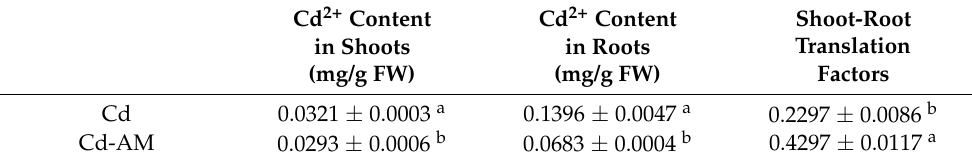
Figure 2. Chlorophyll fluorescence images of (II), Y(NO), Y(NPQ), and qL at steady-state with actinic illumination of 200 µ mol · photons · m − 2 · s − 1 measured at the end of the experiment in leaves of different treatments. The false color code depicted at the bottom of each image ranges from 0.000 (black) to 1.000 (pink). Table 2. Content of Cd 2+ accumulated in the shoot and root of M. truncatula